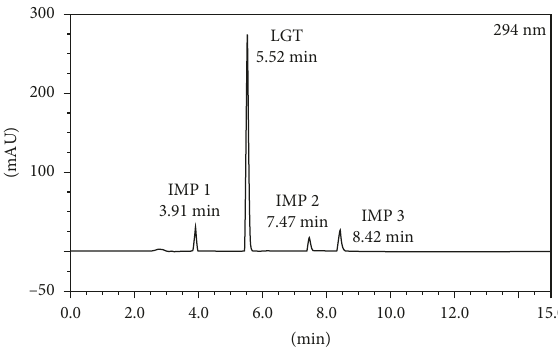
Figure 2: Chromatogram obtained for linagliptin and impurities under optimized chromatographic conditions: IMP 1 (impurity 1 at 3.91min); LGT (linagliptin at 5.52 min); IMP 2 (impurity 2 at 7.47min); IMP 3 (impurity 3 at